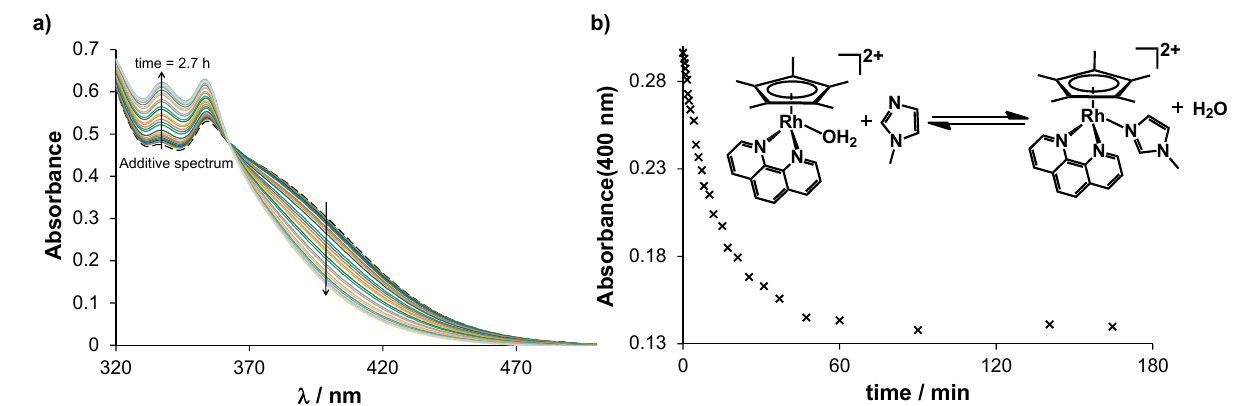
Figure 2. ( a ) Time ‐ dependent UV ‐ vis spectra of the c ([RhCp*(phen)(H 2 O)] 2+ ): c (1 ‐ methylimidazole) = 1:2 mixture under physiological conditions (pH = 7.4 (PBS’ buffer)). ( b ) Time dependence of the absorbance values at 400 nm. { c ([RhCp*(phen)(H 2 O)] 2+ ) = 200 μ M; c (1 ‐ methylimidazole) = 400 μ M; pH = 7.40 (PBS’); t = 25 °C; ℓ = 1 cm}.